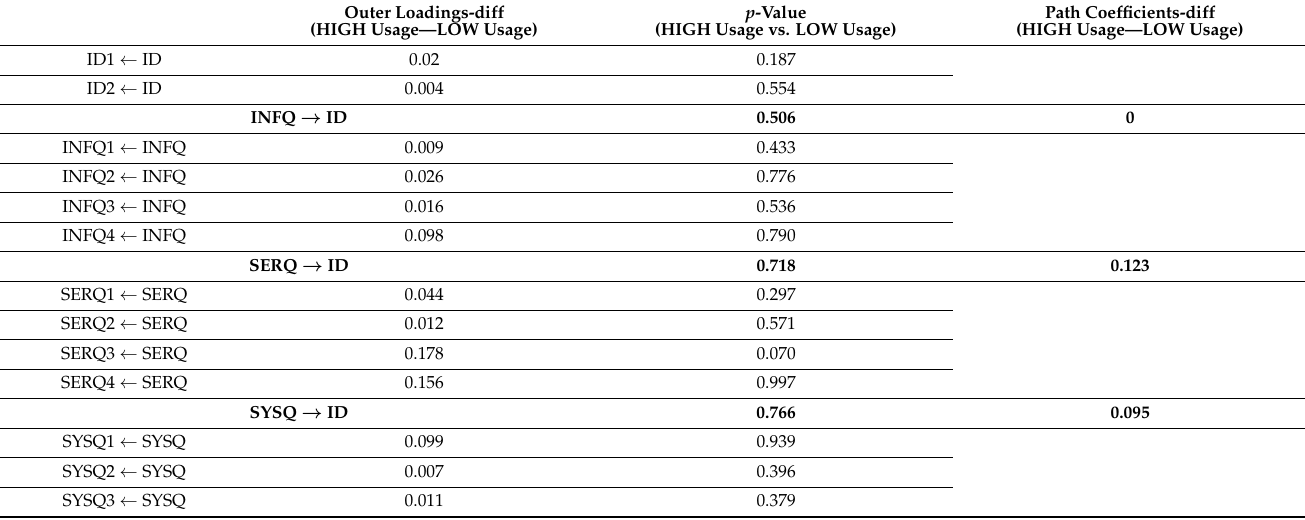
Table 6. Results of PLS-MGA outer loadings and path coefficients.